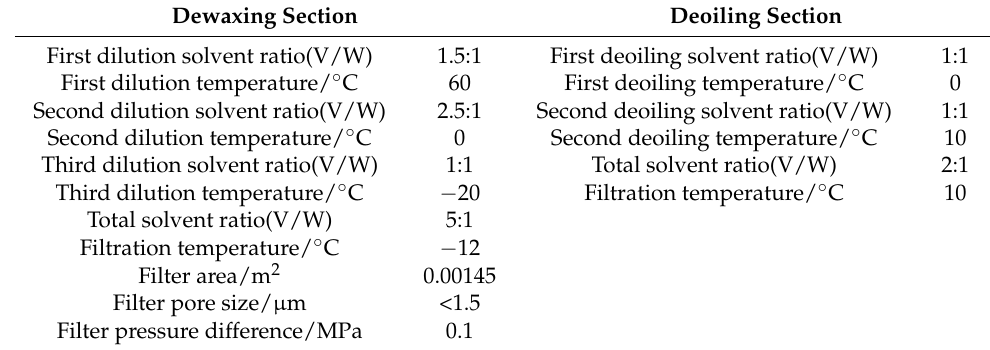
Table 5. Experimental process conditions of the MEK–toluene dewaxing of